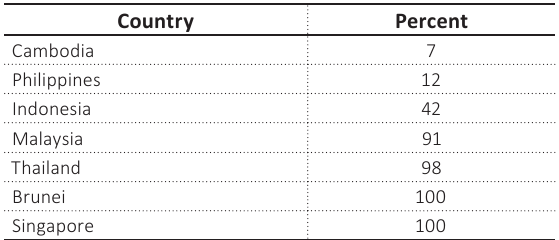
Table 7. Proportion of Internet access in education selected countries